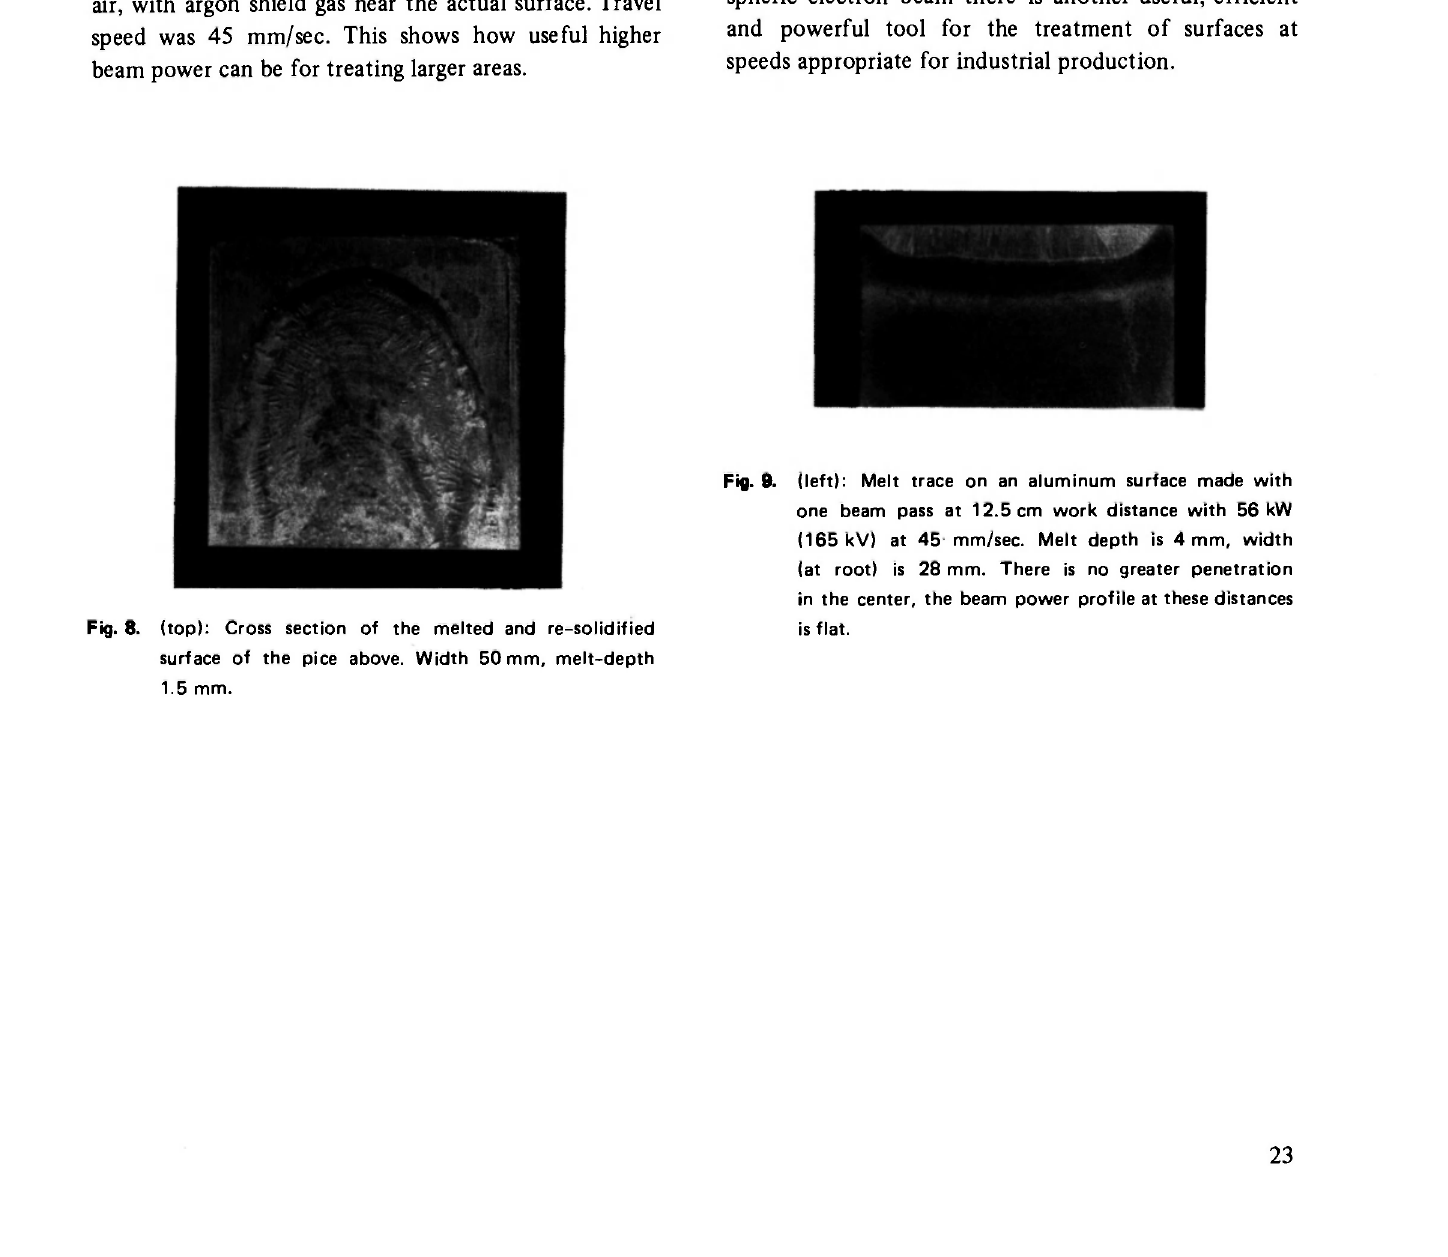
Fig. 9. (left): Melt trace on an aluminum surface made with one beam pass at 12.5 cm work distance with 56 kW (165 kV) at 45 mm/sec. Melt depth is 4 mm, width (at root) is 28 mm. There is no greater penetration in the center, the beam power profile at these distances is